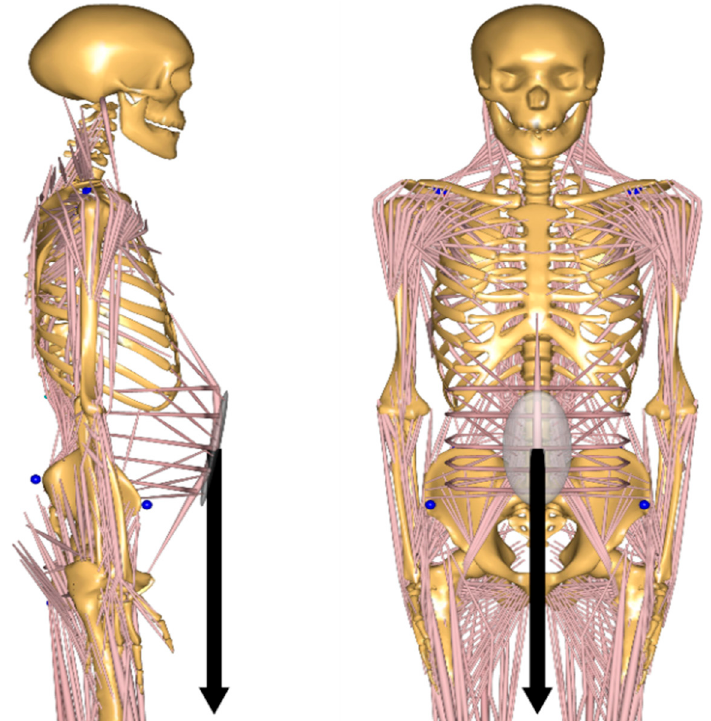
Figure 1. Musculoskeletal model of a pregnant woman in AnyBody Modeling System. Blue dots on the pelvis indicate: ASIS points—anterior superior iliac spine, SACR point—sacrum, which defines the angle of the pelvis tilt. The arrow marks the vector of force, representing the mass of the extra kilograms appearing in the abdominal-pelvic cavity during pregnancy.